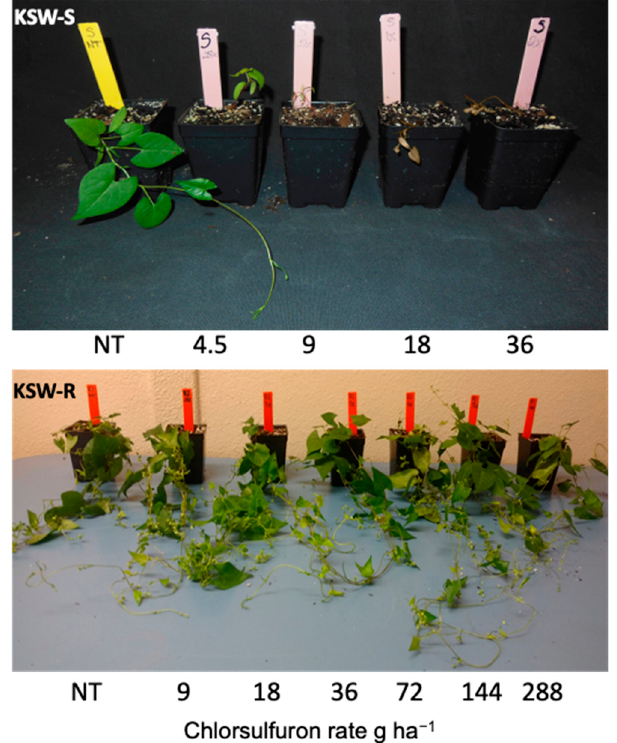
Figure 1. The whole-plant response of KSW-R (resistant) and KSW-S (susceptible) wild buckwheat populations to different rates of chlorsulfuron at 3 weeks after treatment.